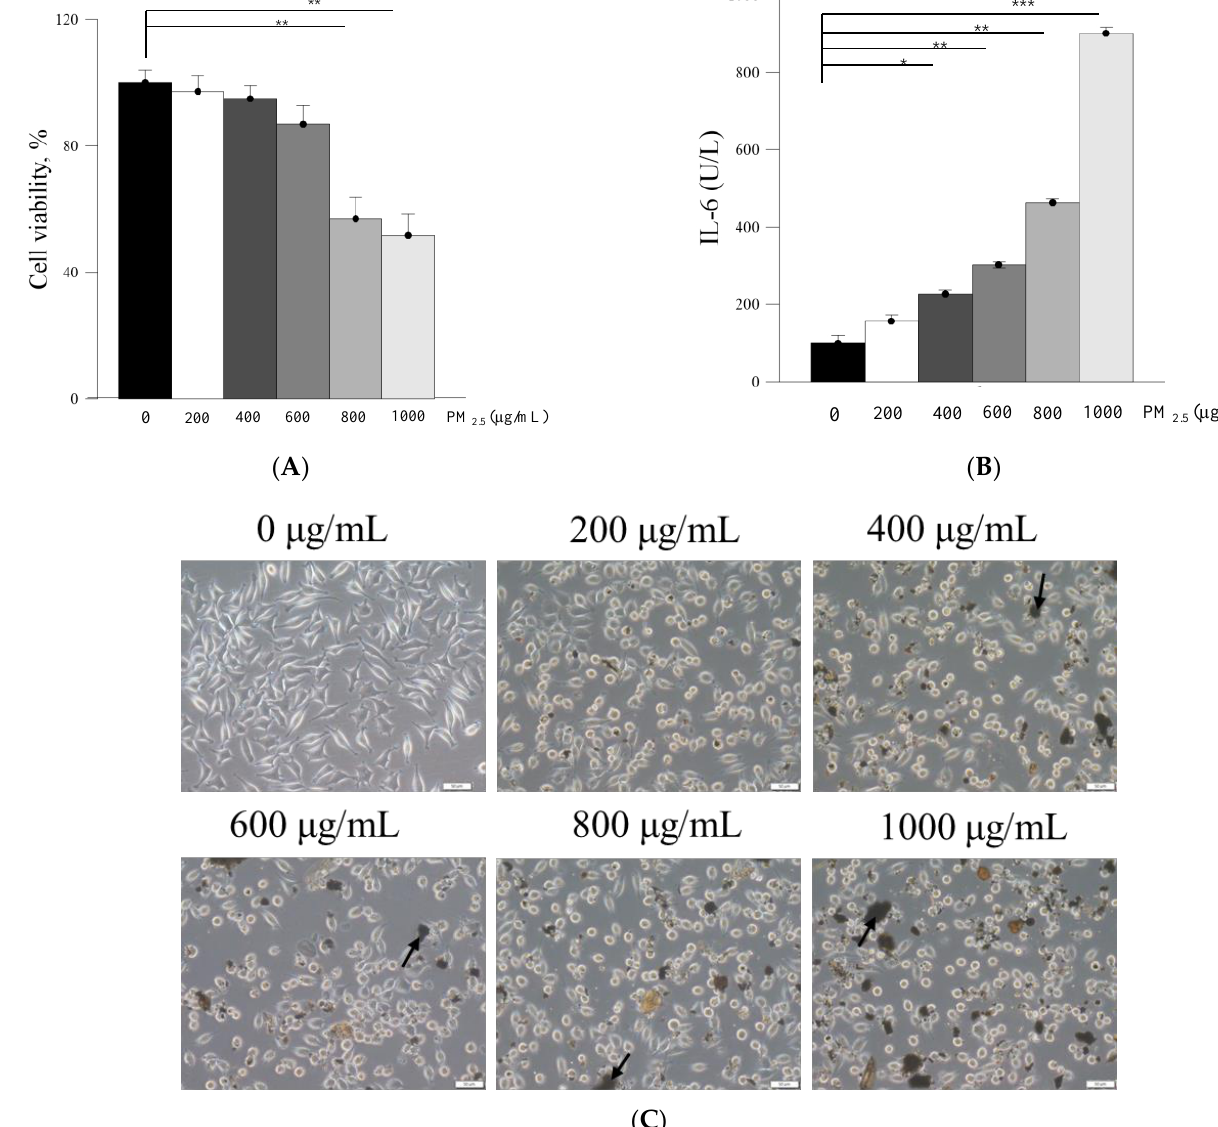
Figure 2. ( A ) 3-(4,5-Dimethylthiazol-2-yl)-2,5-diphenyltetrazolium bromide (MTT) cell viability assay of PM 2.5 for L929 fibroblasts. ( B ) Interleukin-6 (IL-6) level in L929 fibroblasts induced after treatment with PM 2.5 as measured using an enzyme-linked immunosorbent assay. ( C ) Cell morphology after treatment with different PM 2.5 concentrations. Black arrow indicated the precipitated and aggregated PM 2.5 particles. * p < 0.05, ** p < 0.01, *** p < 0.001 by analysis of variance. Bar: 50 μ m